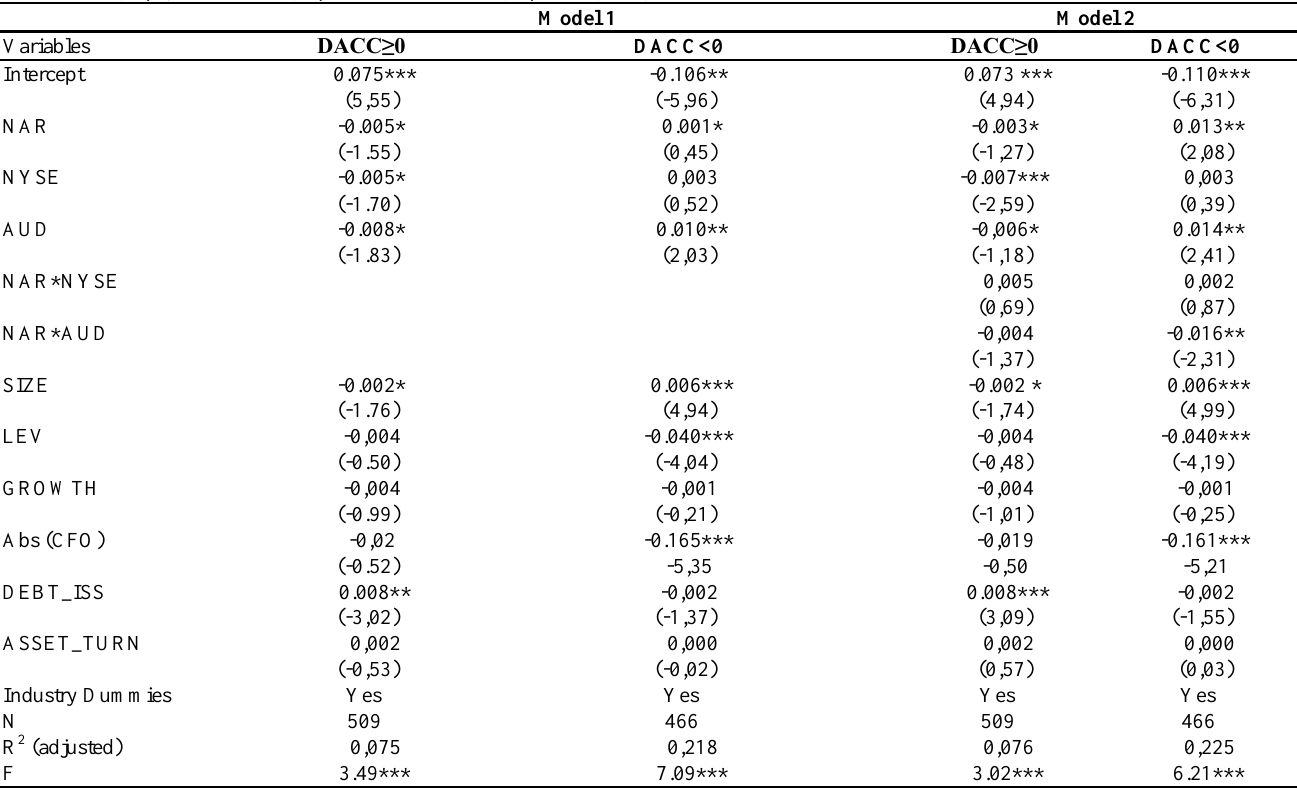
Table 10: Regressions of positive and negative discretionary accruals on independent variables and control variables. Dechow model (sensitivity